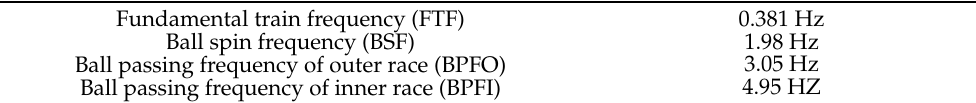
Table 6. Fundamental frequencies of the 6310 SKF bearing.